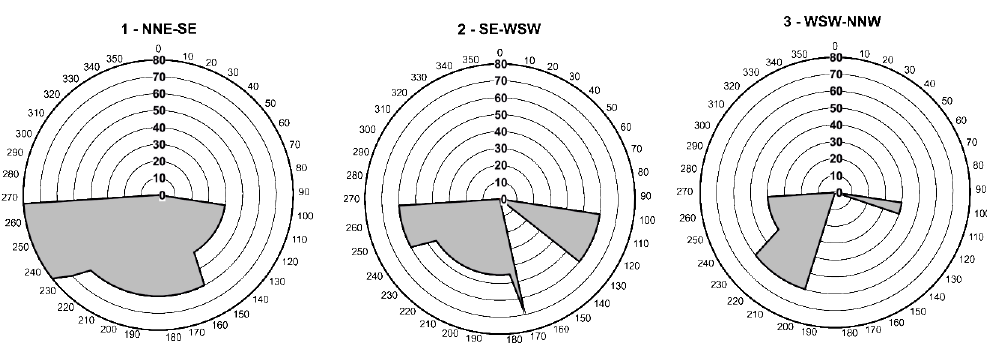
Fig. 9 Fig. 9. Critical slope angles corresponding to the fundamental mechanisms of rock slope instability (plane sliding, wedge sliding and toppling) in the slope dip direction 100 ◦ N ÷ 270 ◦ N (Table 2) for the three structural domains 1, 2 and 3 (Fig. 7).